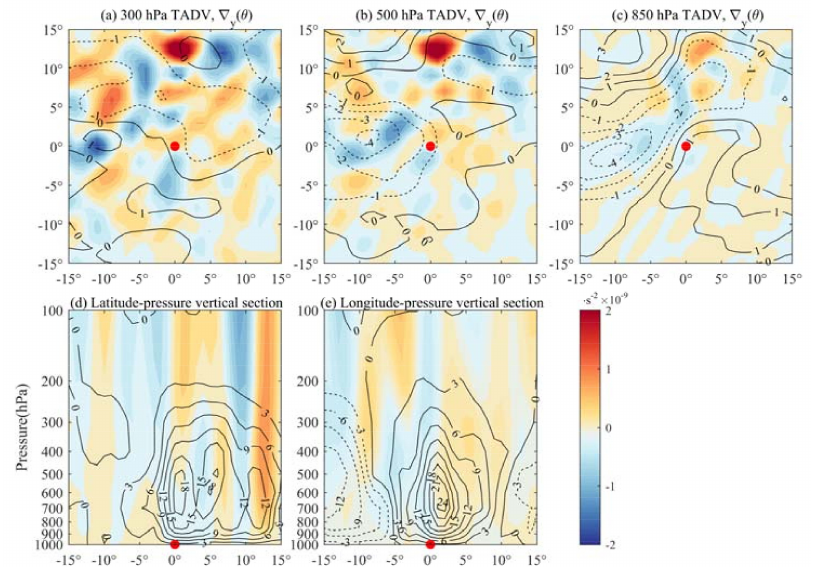
Figure 8. Composite horizontal distribution of the meridional potential temperature gradient (black contours, unit: 10 − 6 K m − 1 ), the temperature advection induced vorticity change (the TADV term, color shading, unit: 10 − 9 s − 2 ) in the cyclone region at the 300 hPa ( a ), 500 hPa ( b ) and 850 hPa ( c ), respectively under the cyclone centered coordinate, and vertical sections of the vertical velocities (contours, unit: − 1 hPa/s) and the temperature advection induced vorticity change (the TADV term, color shading, unit: 10 − 9 s − 2 ) along the 0 ◦ latitude ( d ) and 0 ◦ longitude ( e ) in the cyclone centered coordinate based on the selected cyclones in the Northwest Atlantic. The red spot is the center of the extratropical cyclone at the sea